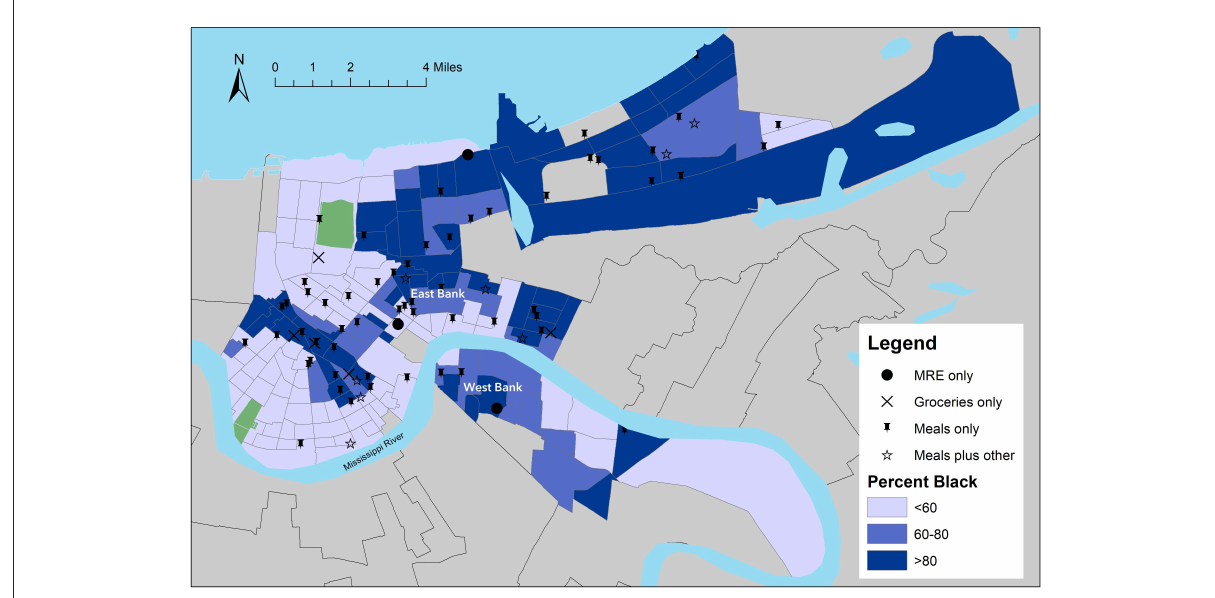
FIGURE2 Location of Emergency Food Distribution Sites in New Orleans Relative to Census Tract-Level Estimates for % NH Black Residents. Data on sites locations provided by NOLA Ready , the city’s emergency preparedness office. Census tract-level estimates of % NH Black residents were obtained from the U.S. Census Bureau (6, 15).